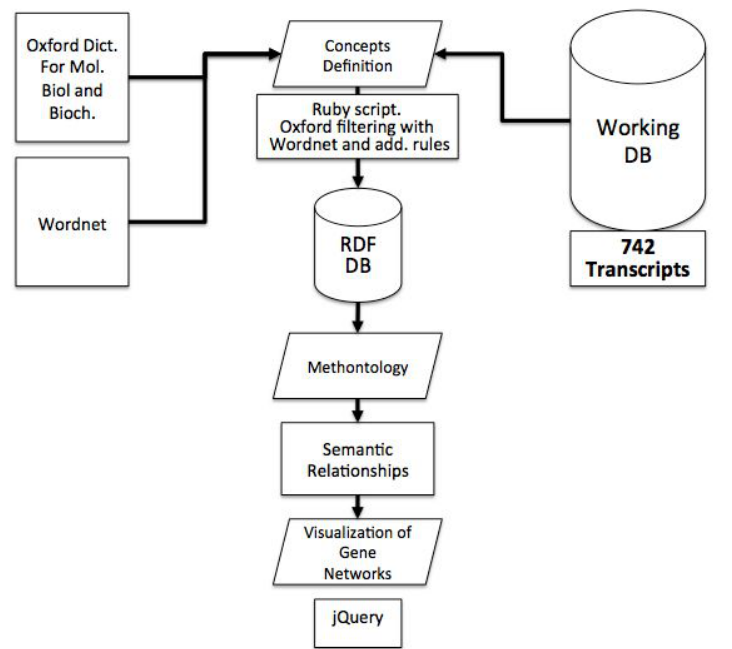
Figure 2: Workflow followed to build up and visualize a network of transcript annotations based on semantics